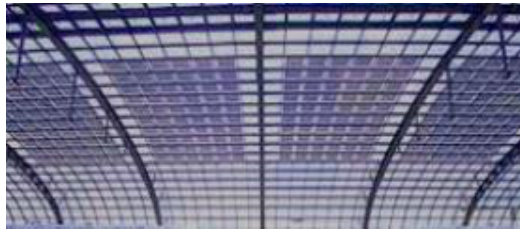
Figure 3. Example of bent structure based on the second generation PV.